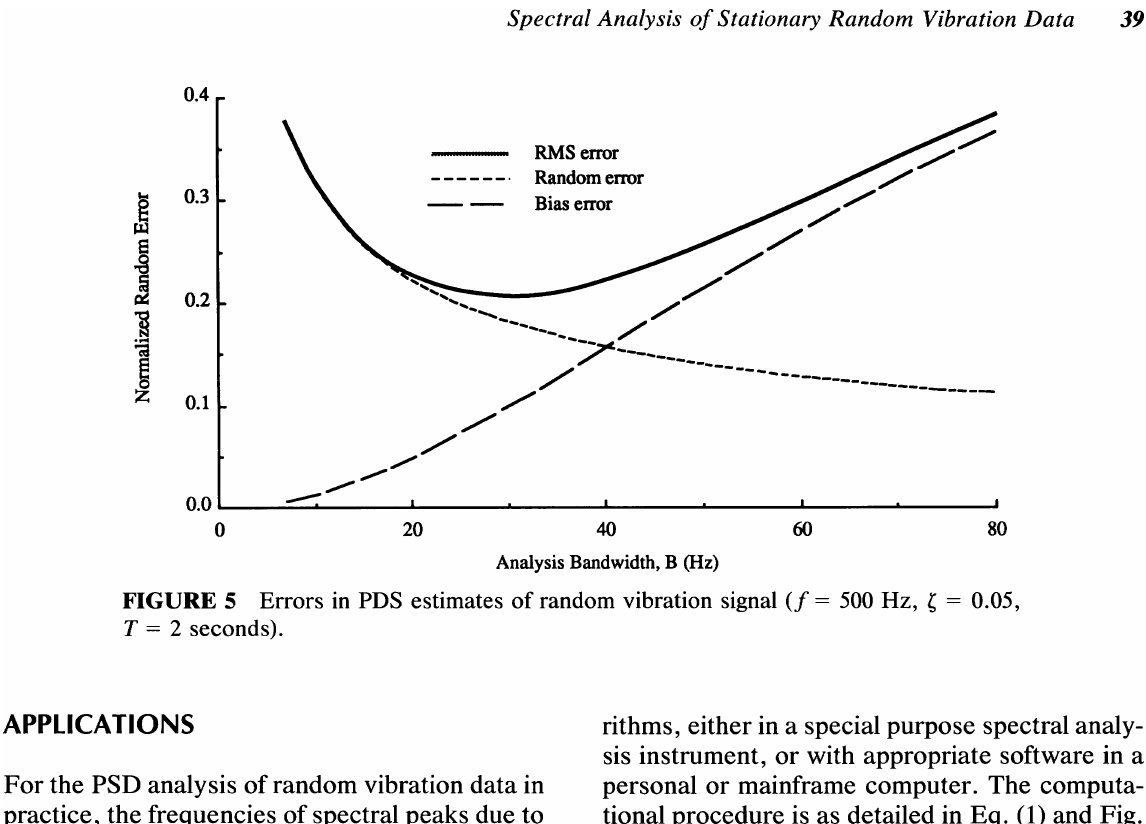
FIGURE 5 Errors in PDS estimates of random vibration signal (f = 500 Hz, , = 0.05, T = 2